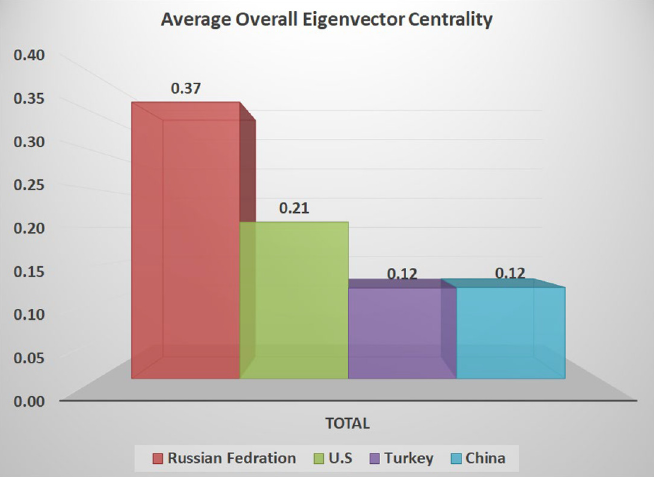
Figure 4. Average overall eigenvector centrality values for the key